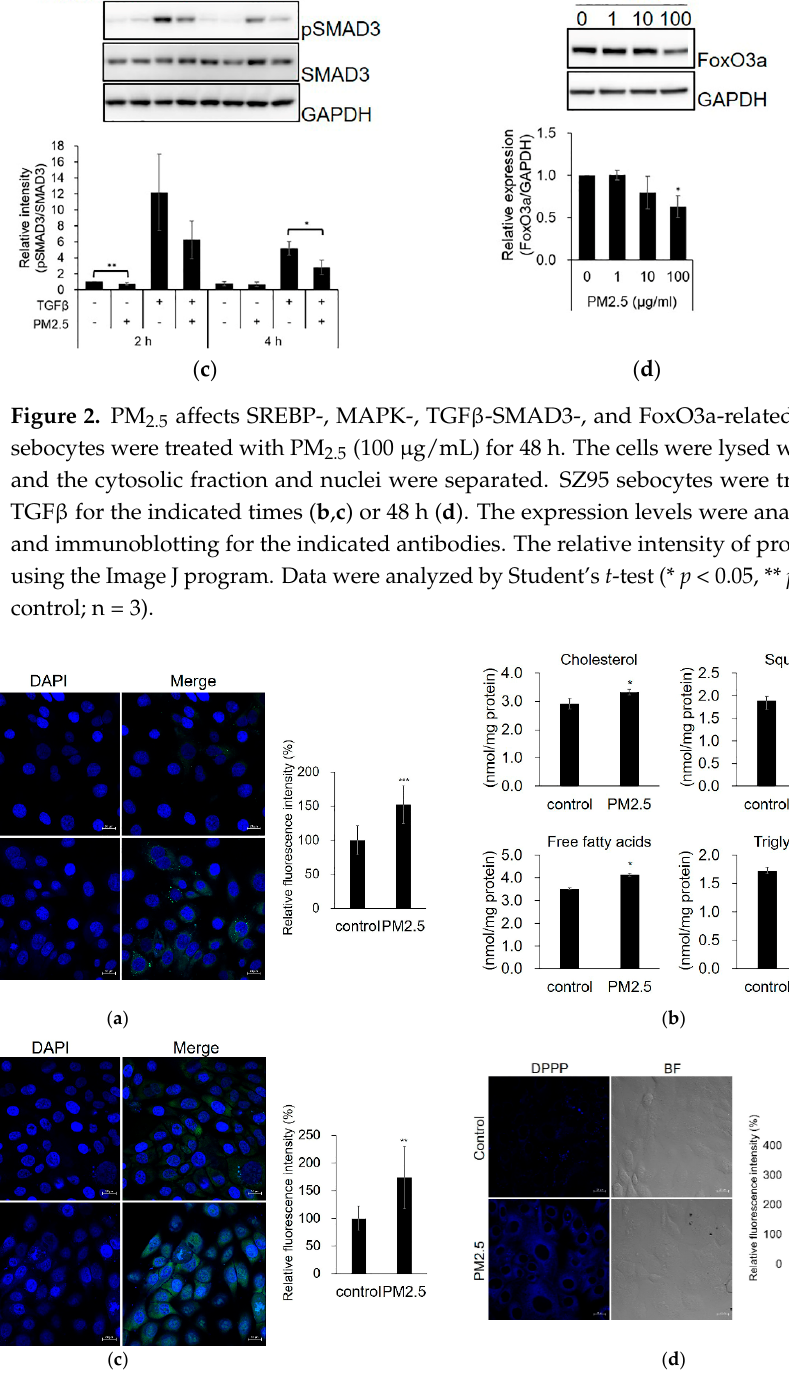
Figure 3. PM 2.5 increases lipid production, ROS generation, and lipid peroxidation. SZ95 sebocytes were treated with PM 2.5 (100 μ g/mL). ( a ) Lipid production was analyzed by Bodipy 493/503 staining (green) and confocal microscopy. ( b ) Relative levels of major lipid classes were determined by LC– MS/MS. ( c ) ROS generation was analyzed by CellROX Green. ( d ) Lipid peroxidation was measured by DPPP staining (blue). Nuclei were stained with DAPI (blue). The fluorescence intensity was calculated using the Zen software and normalized to the DAPI fluorescence intensity (lipid production and ROS generation) or cell number (lipid peroxidation). Data were analyzed by Student’s t -test (* p < 0.05, ** p < 0.01, *** p < 0.001 vs. control). Original magnification: 400×. Scale bars: 20 μ m.